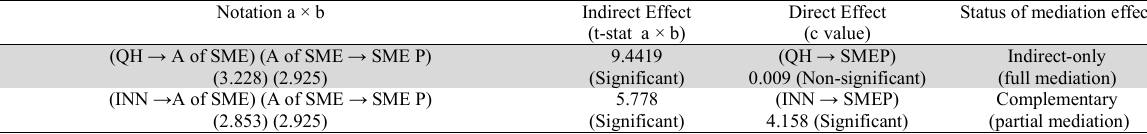
Direct and indirect impact of variables Spain craft sub